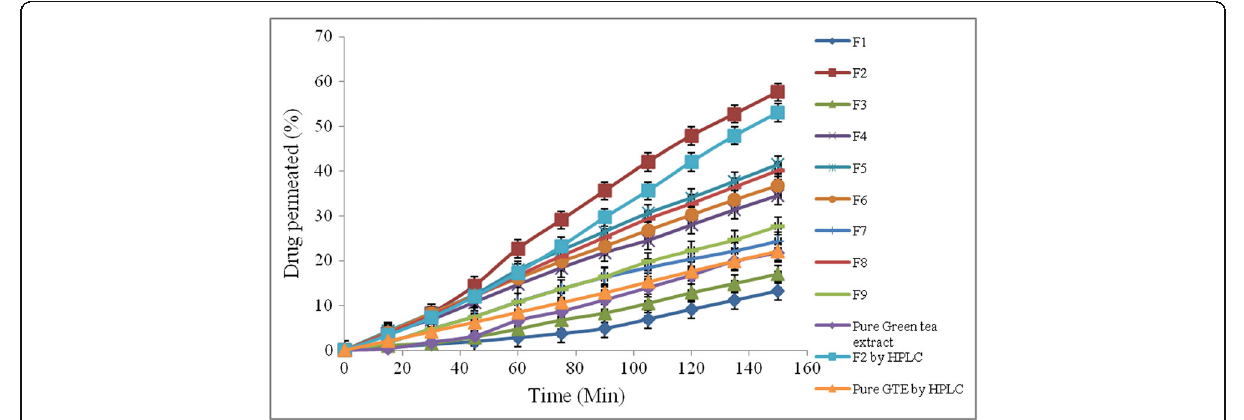
Fig. 4 Ex-vivo study of drug permeated through